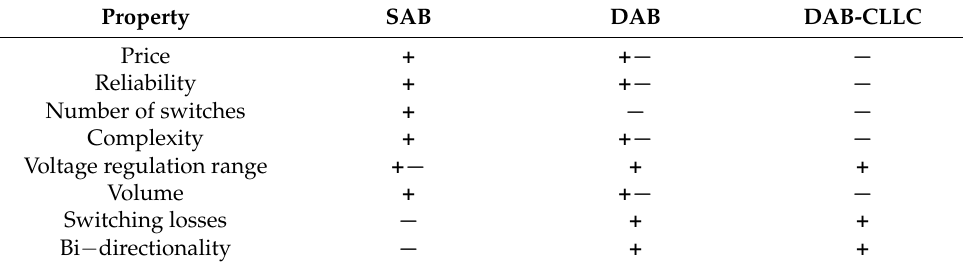
Table 3. Comparison of basic advantages of the analyzed DC/DC converters.